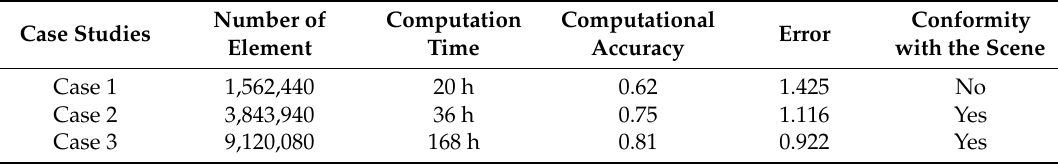
Table 1. The comparison of the grid